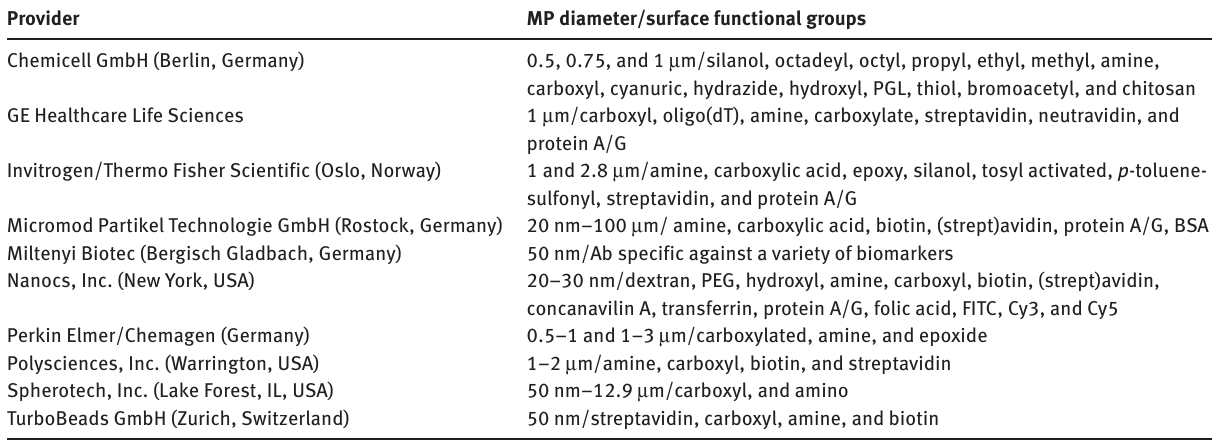
Table 2: Examples of providers of MP and types of MP produced by each of them. Provider MP diameter/surface functional